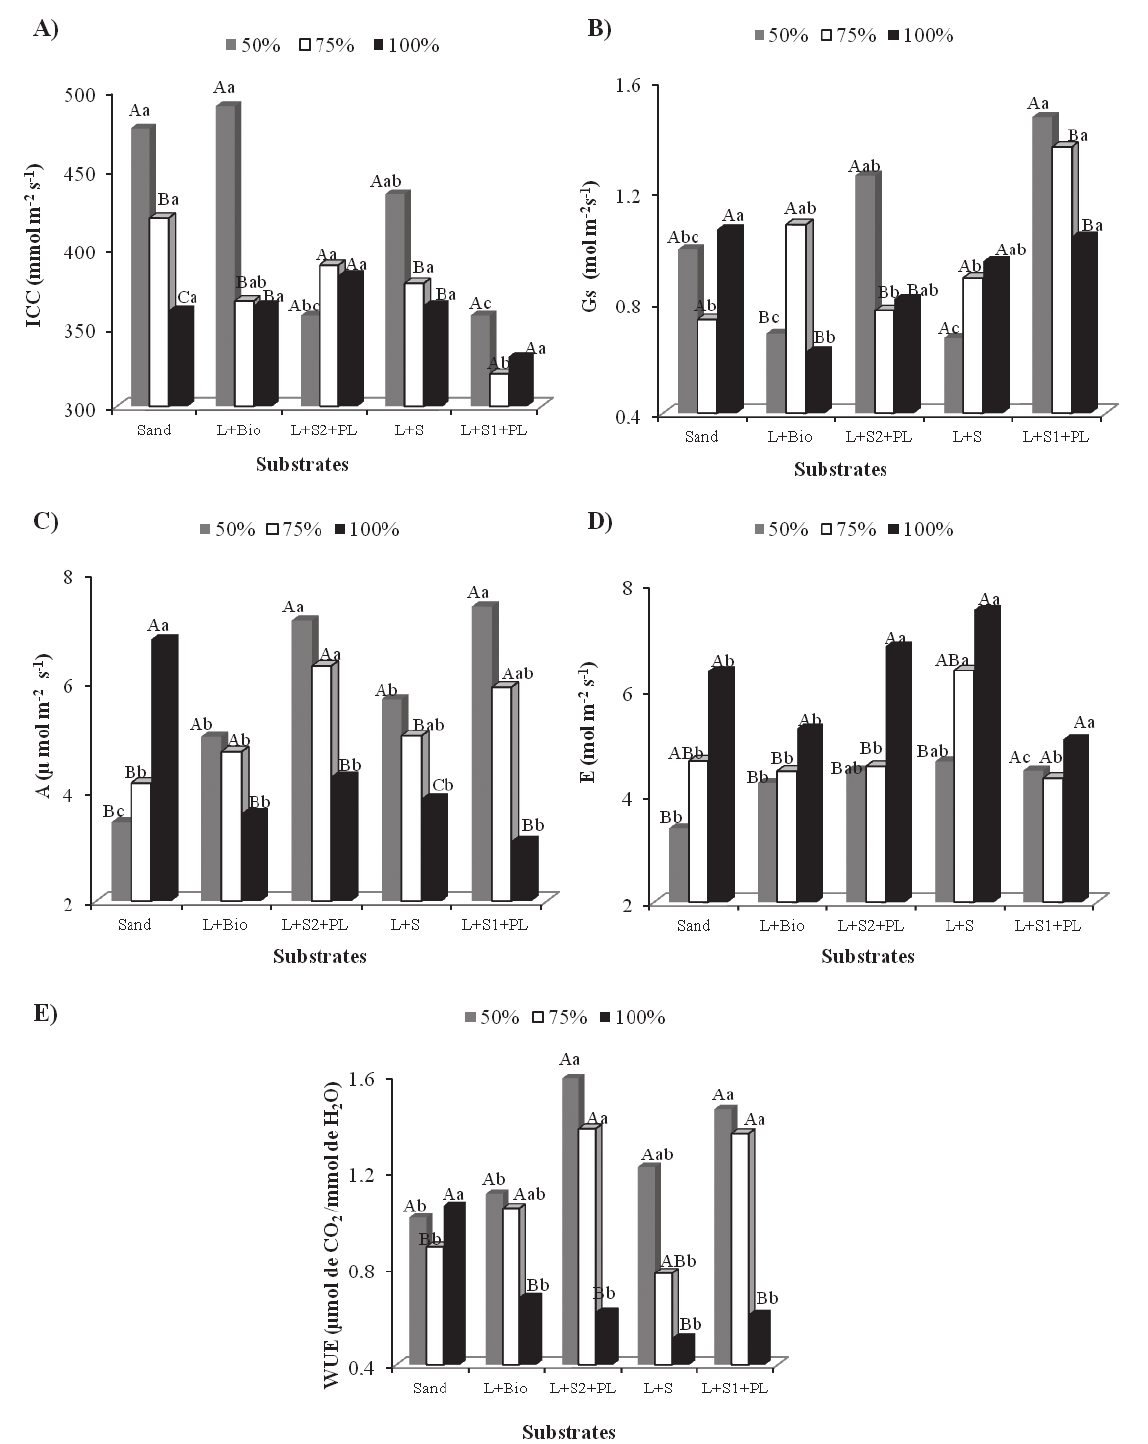
Figure 3 - Internal Carbon Concentration (a), Stomatal Conductance (b), Photosynthesis (c), Transpiration (d) and water use efficiency (e) of uvaia seedlings ( Eugenia pyriformis Cambess.) at 150 days due to different substrates and water holding capacity (WHC). Means with the same capital letter do not differ significantly from the levels of water retention capacity within the same substrate and lowercase for the level of water holding capacity between different substrates by Tukey test at 5%